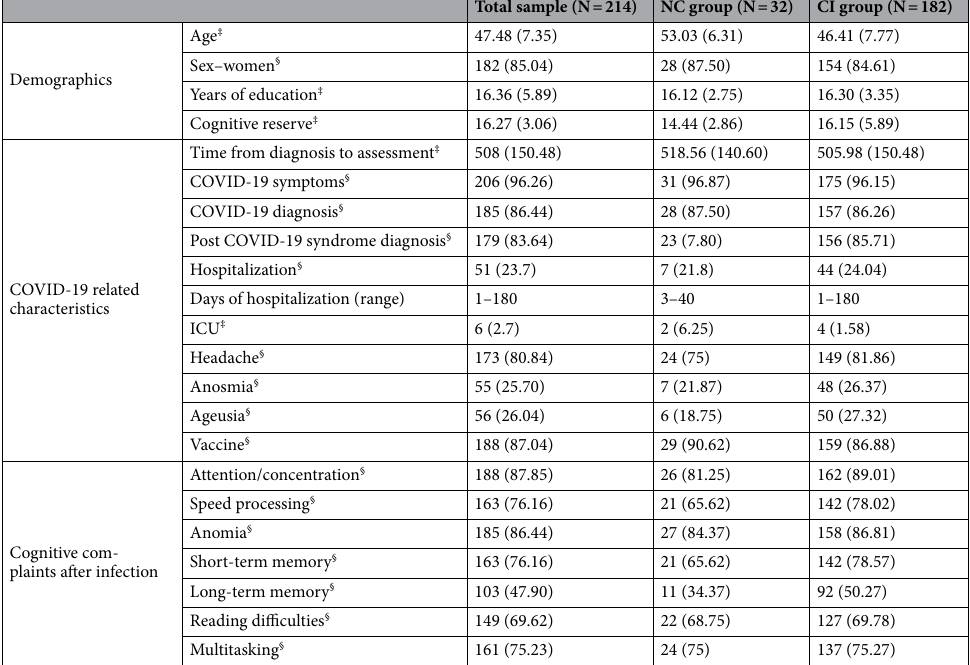
Table 1. Demographic and clinical characteristics of the sample. † NC group = normal cognition group (patients with normal scores in all cognitive tests), CI group = cognitive impairment group (patients with at least one test with impaired scores). ‡ Scores in terms of mean (SD), § scores in terms of N (percentage of